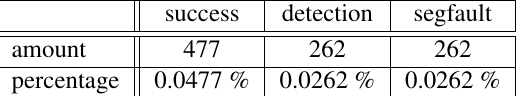
Table 1. Table listing the amount of events occurred after one million executions of the StackGuard exploit.